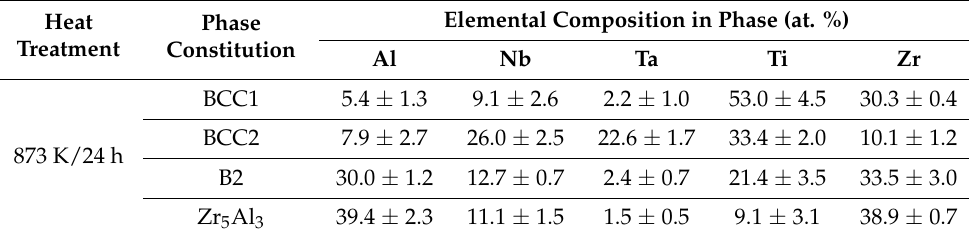
Figure 5. HAADF-STEM image and the corresponding elemental maps of the S3 RHEA after aging at 873K by the Super-X EDS. Table 2. Phase constitution and elemental composition (at. %) in phase of the aged S3 RHEA at 873 K for 24 h.